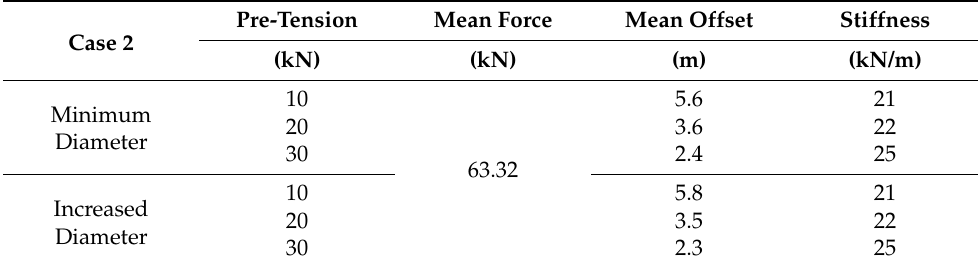
Table 8. Mean offset and stiffness, Case 2.